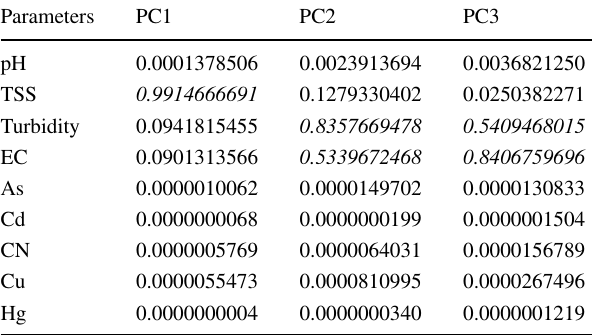
Table 4 Summary of PCs loadings for input parameters Parameters